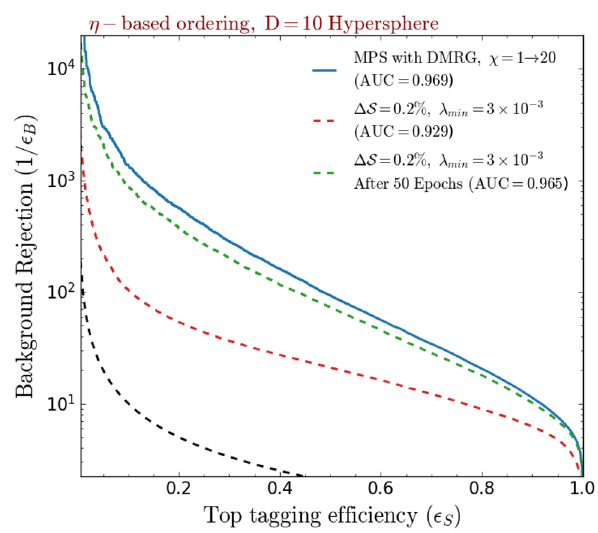
Figure 11 . ROC curves to compare the original network (solid blue), compressed network (dashed red) and the compressed network after 50 epochs (dashed green). The dashed black curve shows the random